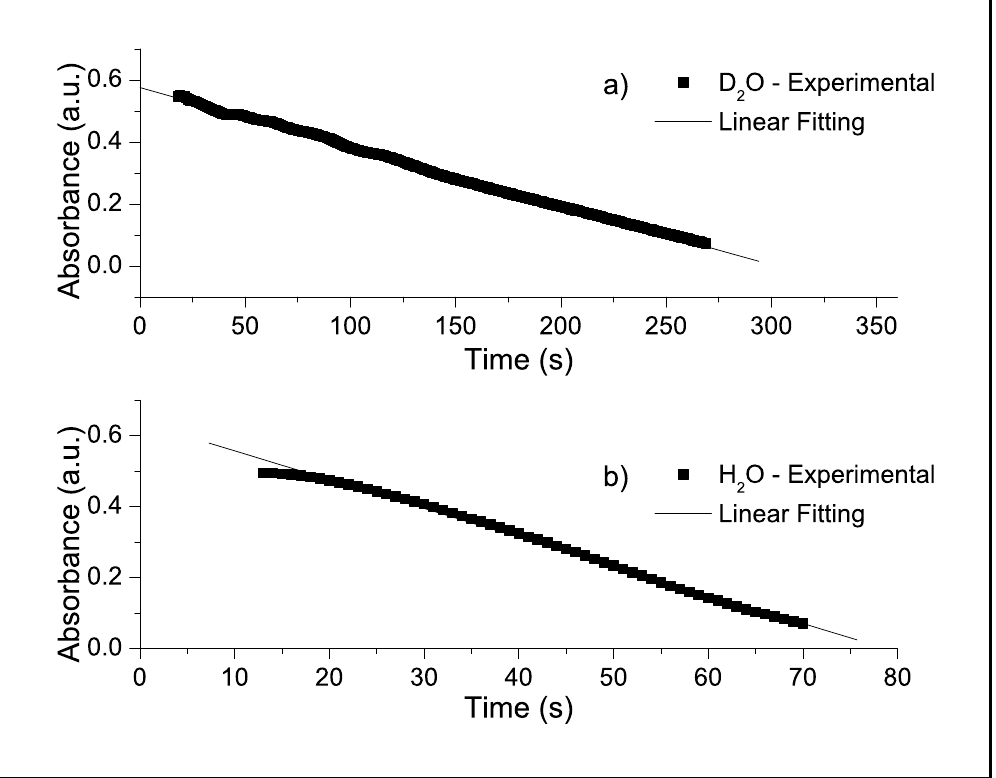
Figure 3. Disappearance of Br followed spectrophotometrically at 500 nm in H 2 system (b). Solution composition was [MA] = 0.25 M, [Br